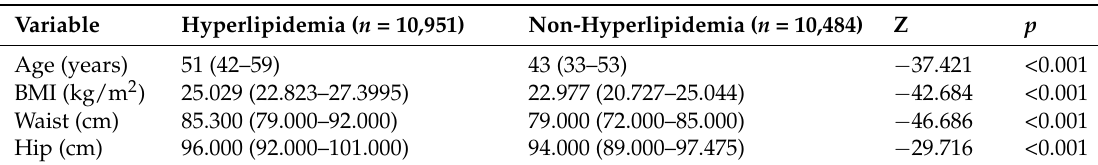
Table 2. Distribution of age, BMI, waist and hip circumferences between participants with and without hyperlipidemia (( n = 21,435), M (Q 1 –Q 3